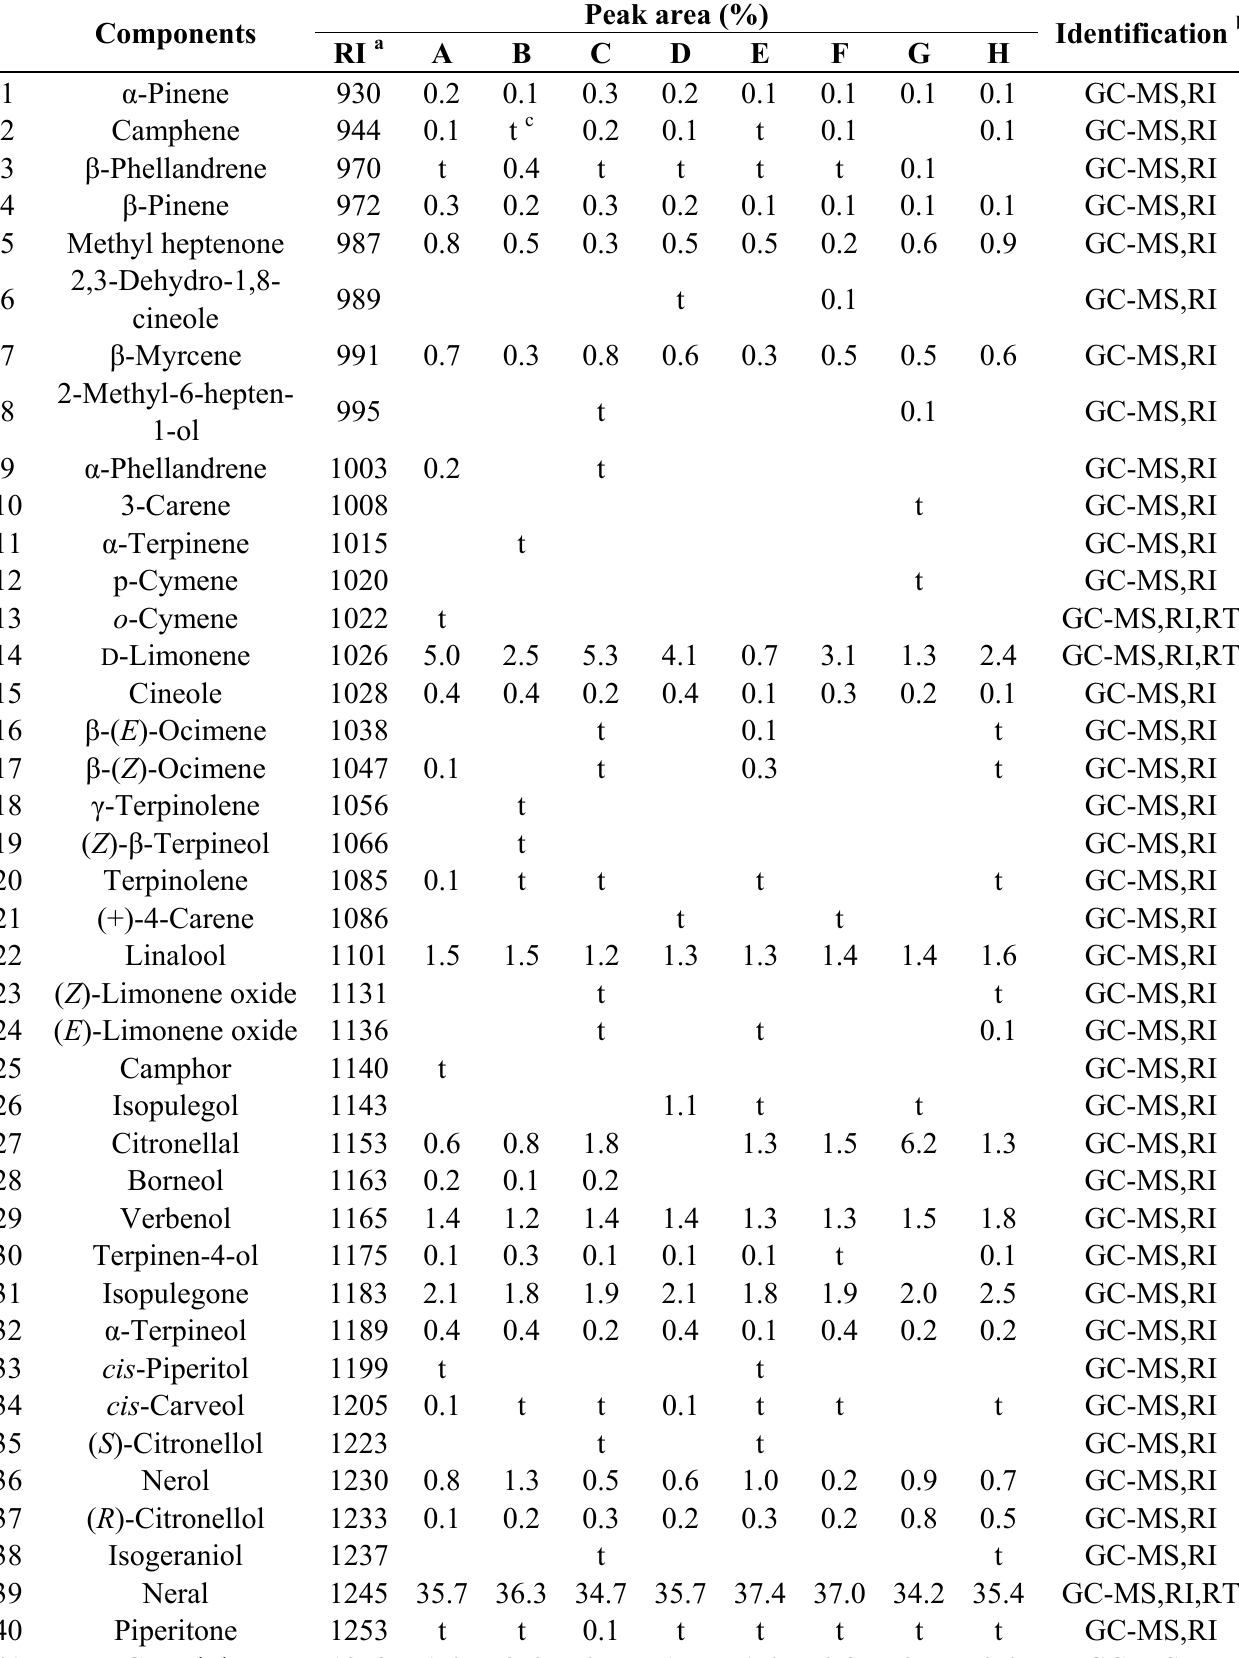
Table 2. Essential oil compositions of Litsea cubeba harvested from different areas.